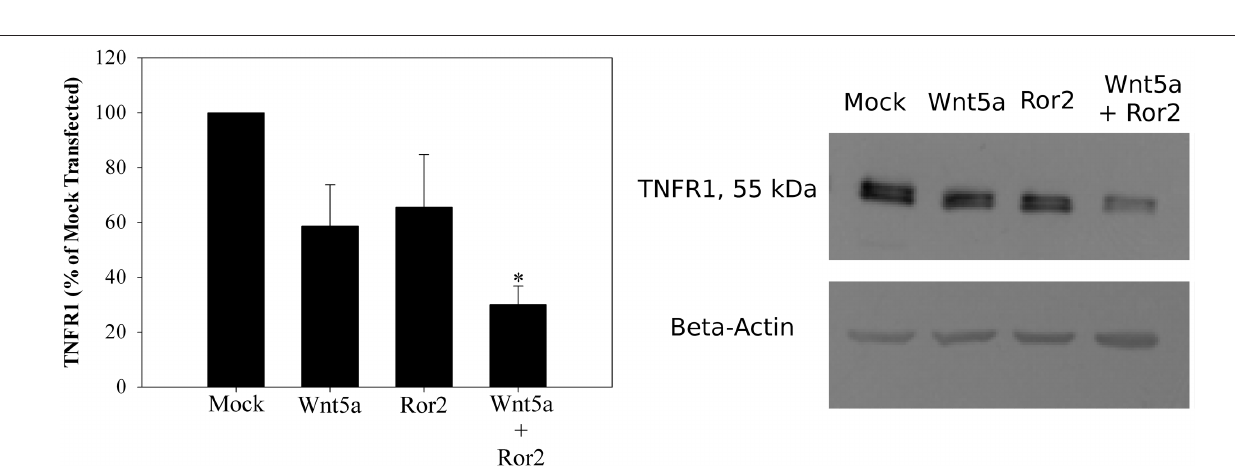
FiguRe 4 | Wnt5a/Ror2 decrease TNFR1 protein expression. HT29 cells were transiently transfected with 1 μg WT–Ror2 (or 1 μg pcDNA3.1 as a control) for 24 h, serum starved for 24 h and treated with Wnt5a conditioned medium for